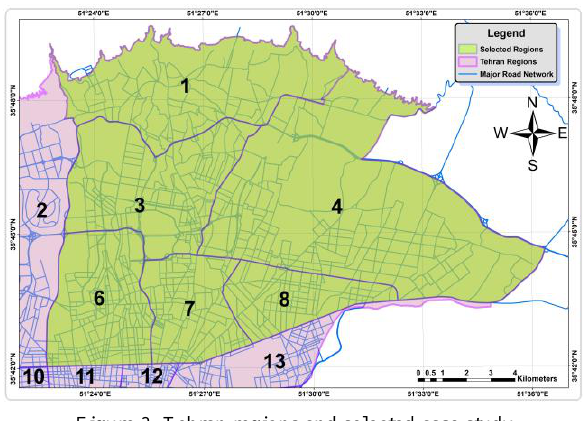
Figure 3. Tehran regions and selected case study